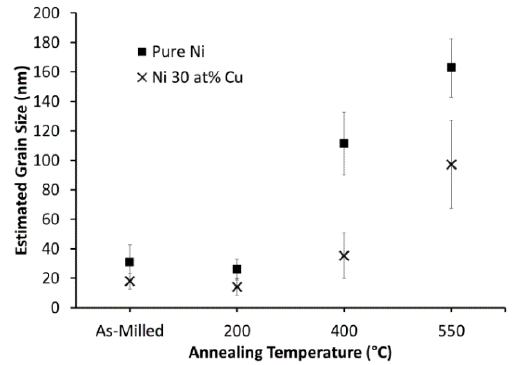
Figure 8. Grain size analysis for pure Ni and Ni 30 at % Cu milled for 20 min and annealed at the given temperatures. Error bars represent one standard deviation from the mean.